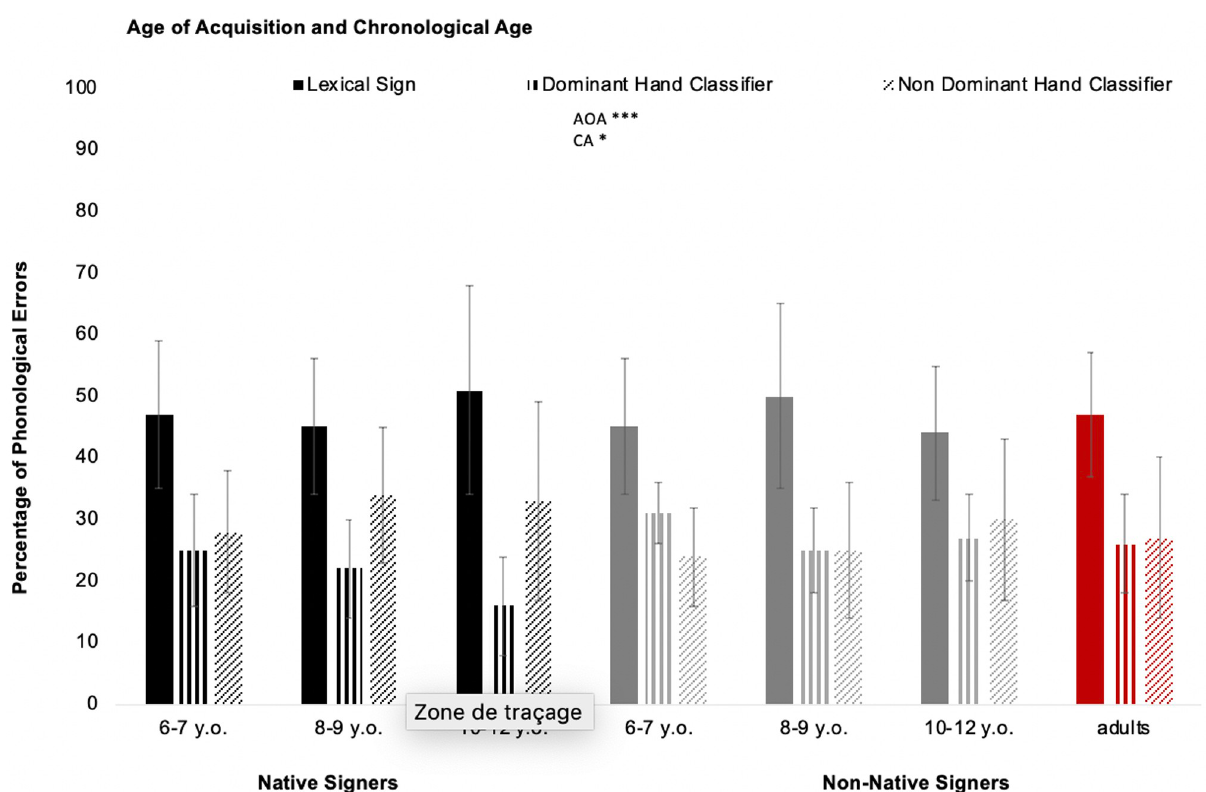
Fig 5. Effect of age of acquisition and chronological age on phonological errors according to the sign category repeated: Lexical Sign, Dominant- Hand Classifier, and Non-Dominant-Hand Classifier. Adults are considered as the control group ( ��� p < .001; �� p < .01; � p < .05; n.s. p > .05).